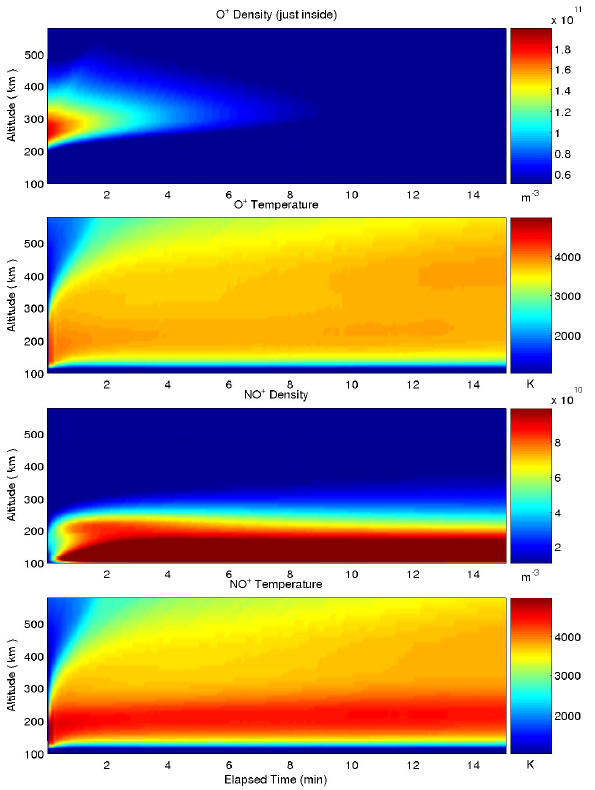
Fig. 9. Time evolution of electron parameters just on the edge of the arc, where the parallel current densities reach their peak values.